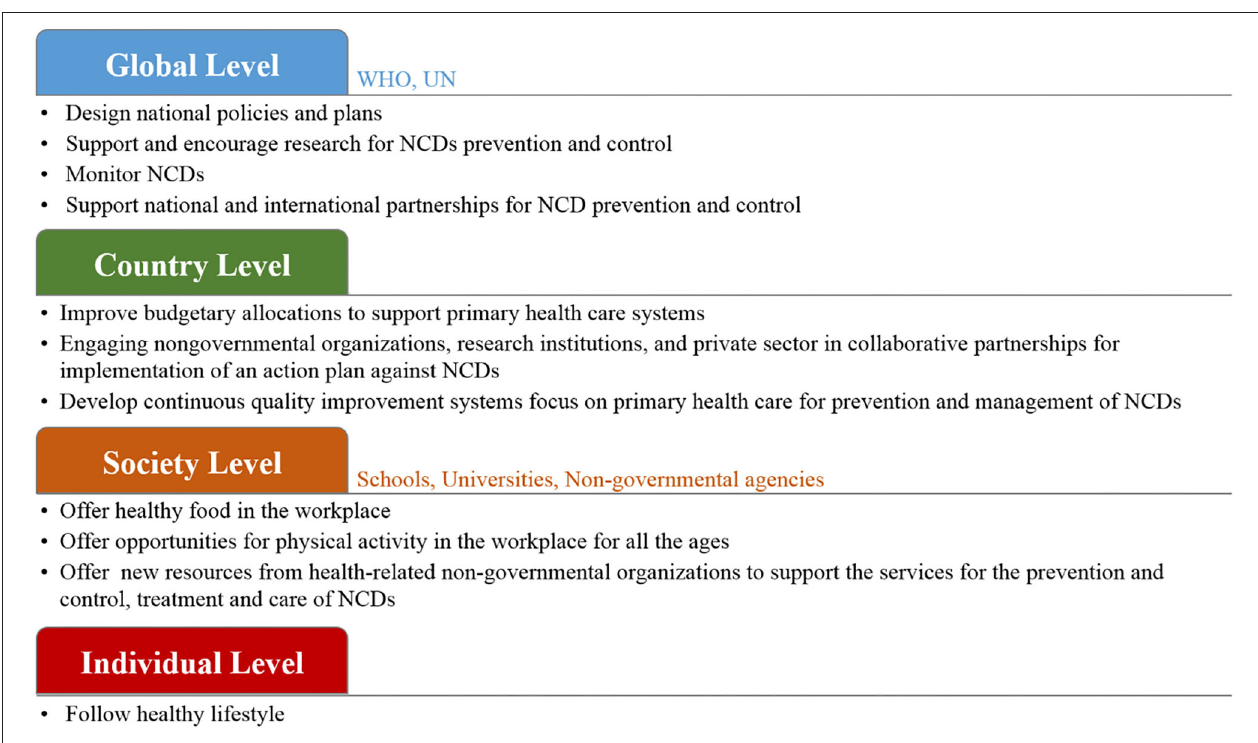
FIGURE 3 | The proposed prevention management of NCDs with small and large-scale human